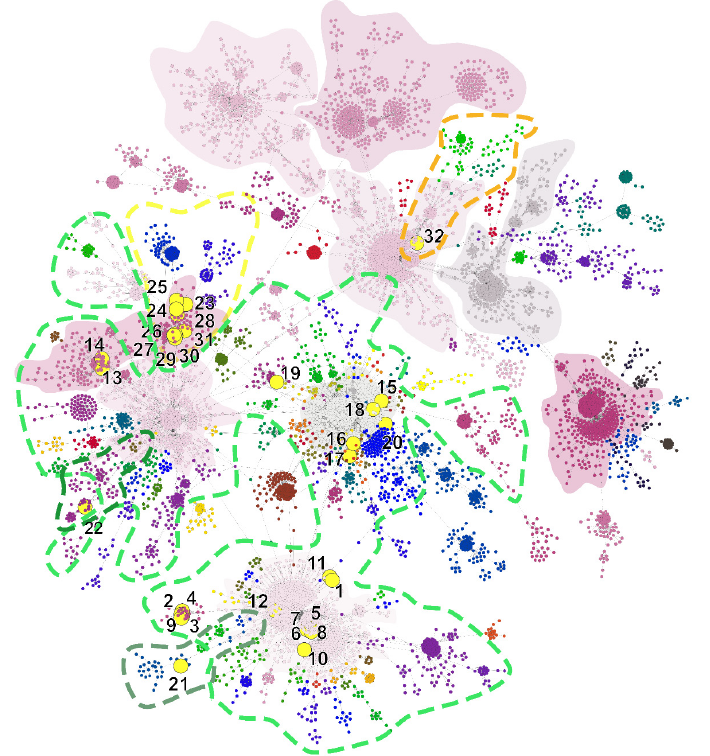
Figure 1. Genetic network analysis of 7864 SARS-CoV-2 complete genomic sequences. Hungarian strains are indicated with numbered yellow dots—numbers referring to Table 1. The nine major clades are represented by a solid color. Genetic lineages are marked with colored dotted lines, where green lines are bordering B 1, B 1.1 and B 1.11; yellow and orange lines mark B 1.5 and B 3, respectively. Dark shaded background areas represent the area of defined